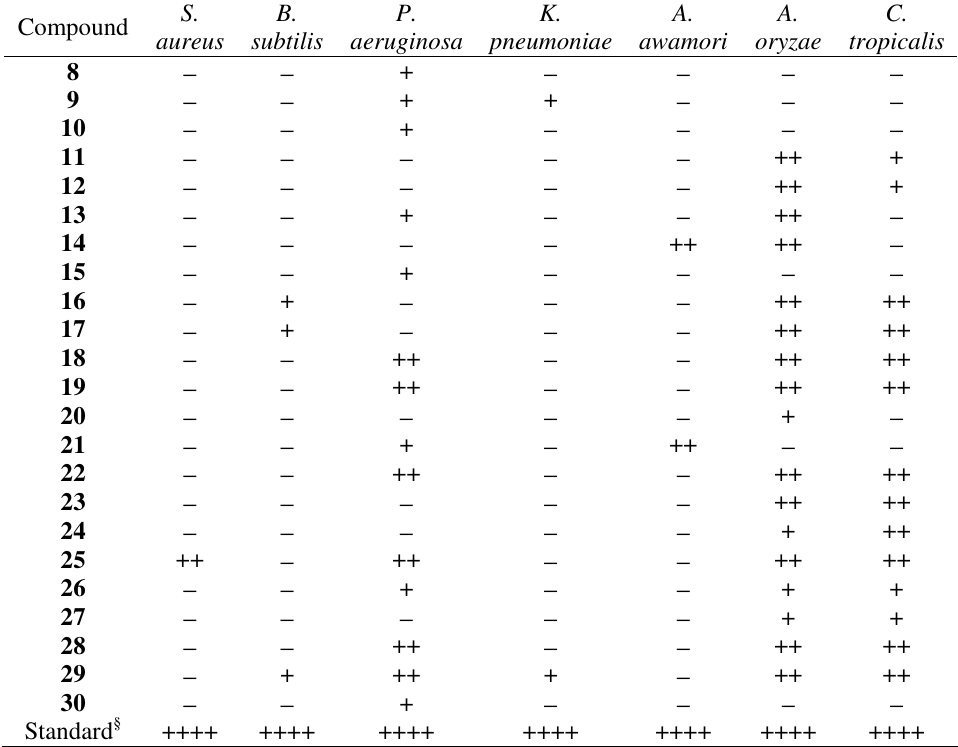
Table 2. Antimicrobial activity of compounds 8-30 